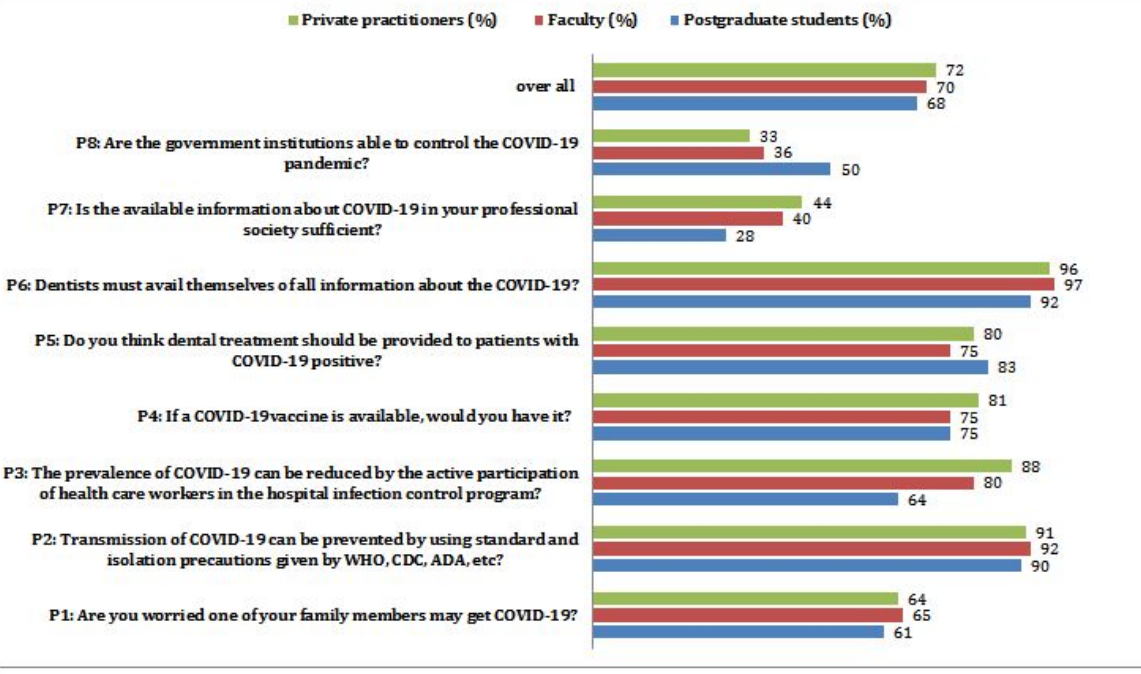
Figure 4. Overall Perception scores (%) of pediatric dentists participated in the study. Table 3. Details of mean values of pediatric dentists based on occupations.